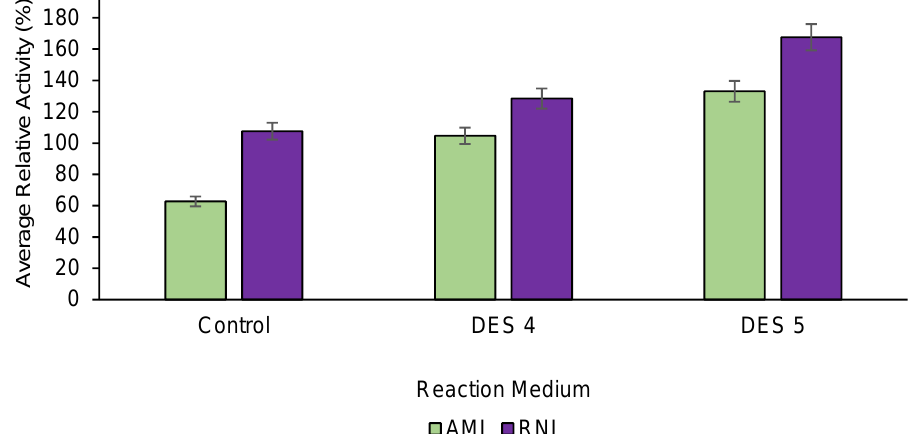
Figure 6. Relative lipase activity in the presence of DES 4 and DES 5. AML = Amano lipase PS, from Burkholderia cepacian , ≥ 30,000 U g − 1 ) and RNL = Rhizopus niveus lipase, ≥ 1.5 U mg − 1 ). Means with different superscript alphabets differ considerably ( p < 0.05). DES4 = Menthol:Octanoic acid and DES5 = menthol:decanoic acid (1:1). Conditions: concentration of lipase: 1 mg mL − 1 , 2 h, 300 rpm, 40 °C, and pH 7.0. Table 2. Measurements of lipase activity and efficiency when DES 5 is present.